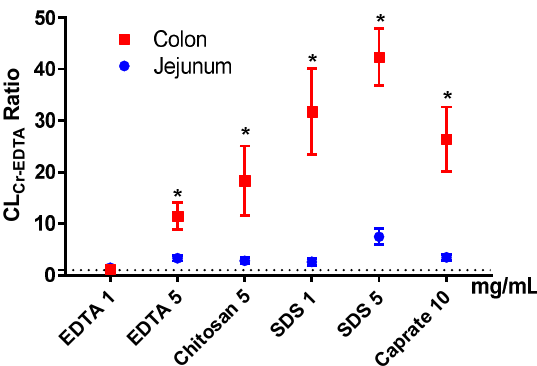
Figure 5. The mean ± SEM rat jejunal (historical data) and colonic blood-to-lumen 51 Cr-EDTA clearance (CL Cr-EDTA ) ratio ( n = 6), after intestinal perfusions of a control solution for 60 min, followed by a 75-min perfusion of any of six permeation enhancing (PE) test formulations. The control and test formulation perfusate pH was 6.5 for the PEs: sodium dodecyl sulfate (SDS) at 1 and 5 mg / mL, chitosan at 5 mg / mL, and ethylenediaminetetraacetic acid (EDTA) at 1 and 5 mg / mL. The control and test formulation perfusate pH was 7.4 for caprate at 10 mg / mL. All formulations were solutions, except caprate which was a suspension (its solubility at pH 7.4 is 5 mg / mL). A * represents a significant di ff erence in jejunal and colonic CL Cr-EDTA ratio (two-way ANOVA, Holm–Sidak).